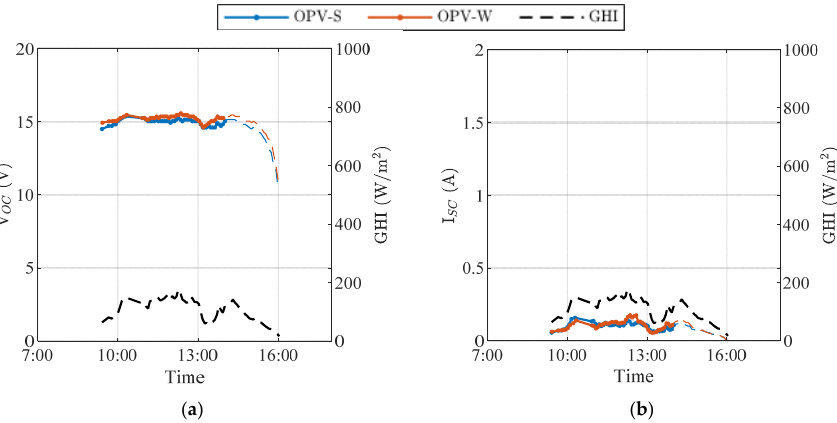
Figure 12. Example of raw data on a cloudy day: ( a ) open-circuit voltage, V oc ; ( b ) short-circuit current, I sc , recorded on 13 November 2020.